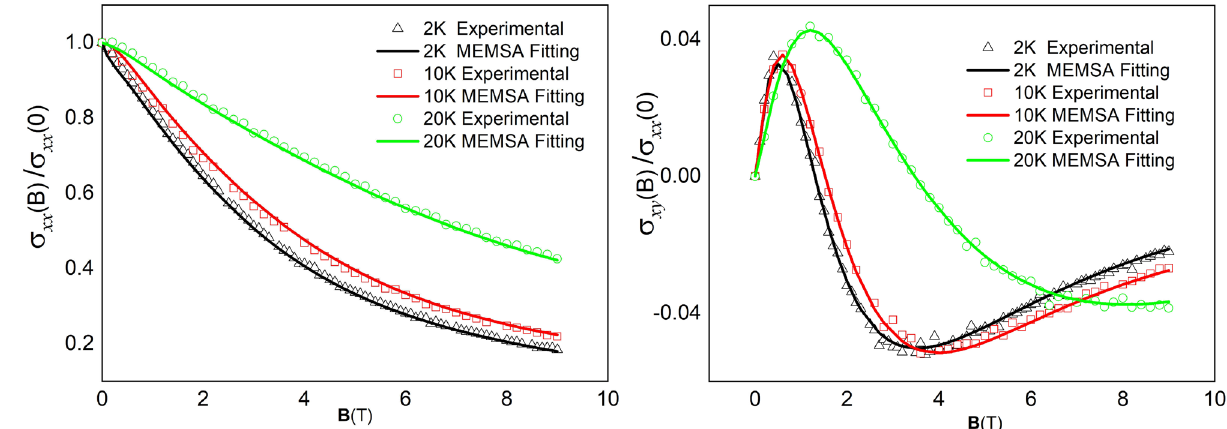
Figure 2. The experimentally measured conductivity (left panel, dots), Hall conductivity (right panel, dots), and their MEMSA fitting (solid lines).